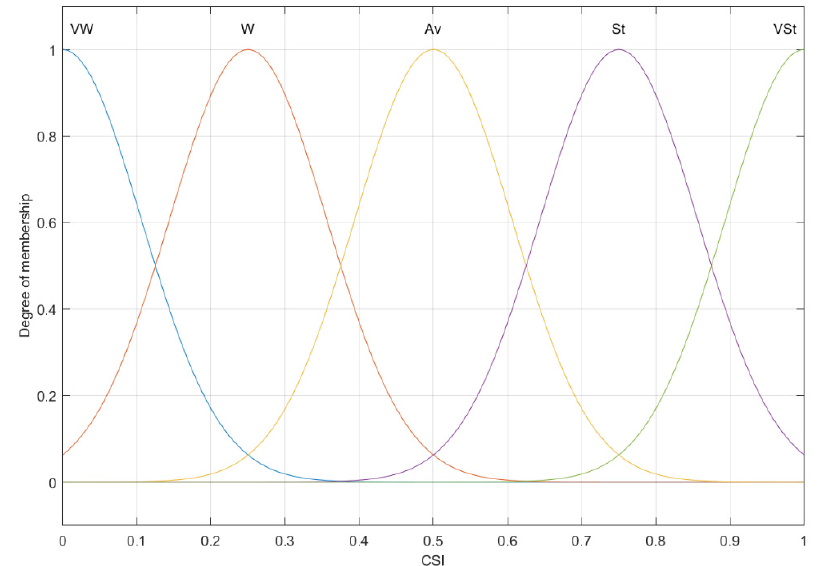
Figure 5. Fuzzy membership function for the second input CSI. As for the fuzzy output, five linguistic terms were also chosen to explain the universe of discourse for P rk : Very Low (VL), Low (L), Middle (Md), High (H), and Very High (VH), as shown in Figure 6. The fuzzy output range value [0.4 0.8] was chosen because the highest PDR performance from the initial observation only indicated the corresponding P rk range. The mean values for the Very Low (VL), Low (L), Middle (Md), High (H), and Very High (VH) terms were set to: [0.4], [0.5], [0.6], [0.7] and [0.8], respectively.